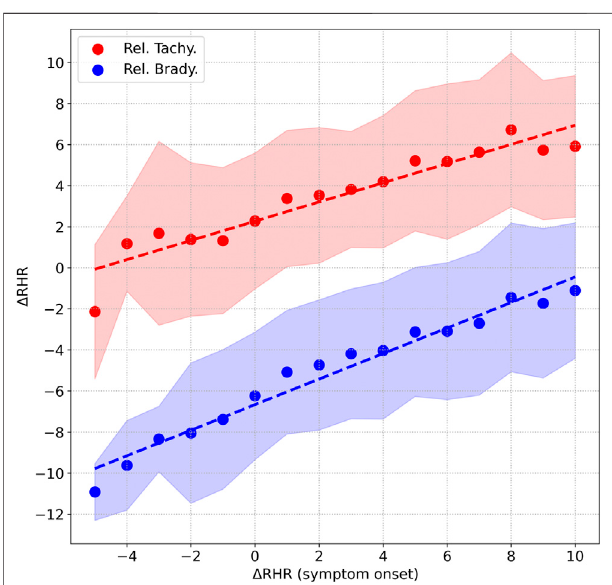
FIGURE 6 | Correlation between the peak value of Δ RHR measured during symptom onset, and 1) peak value of Δ RHR in the second relative tachycardiawindowshowninred,2)minimumvalueof Δ RHRmeasuredinthe relative bradycardia window shown in blue. The shaded areas represent the 1 standard deviation